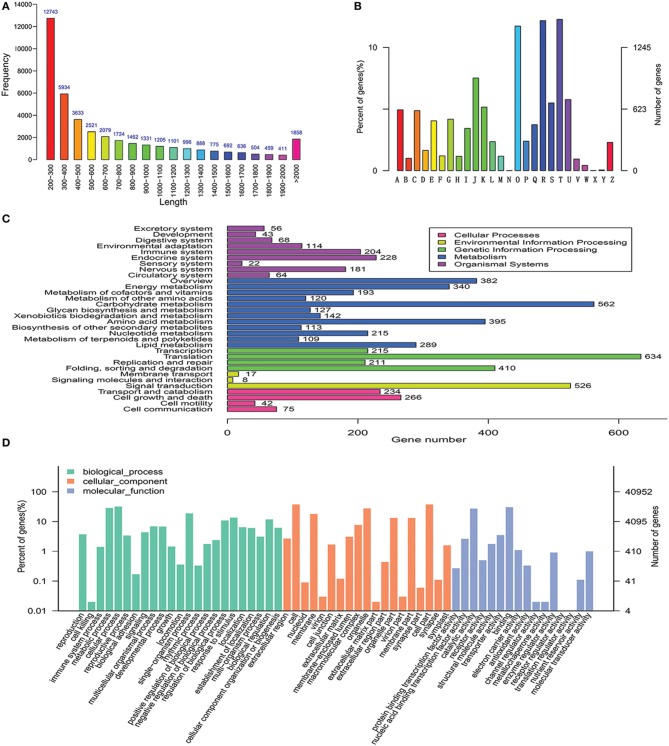
De novo assembly, annotation and functional classification. (A) Length distribution of the unigenes. (B) KOG classification assigned to unigenes. (C) KEGG classification of assembled unigenes. (D) Gene ontology classification of assembled unigenes. A, RNA processing and modification; B, Chromatin structure and dynamics; C, Energy production and conversion; D, Cell cycle control, cell division, chromosome partitioning; E, Amino acid transport and metabolism; F, Nucleotide transport and metabolism; G, Carbohydrate transport and metabolism; H, Coenzyme transport and metabolism; I, Lipid transport and metabolism; J, Translation, ribosomal structure, and biogenesis; K, Transcription; L, Replication, recombination, and repair; M, Cell wall/membrane/envelope biogenesis; N, Cell motility; O, Posttranslational modification, protein turnover, chaperones; P, Inorganic ion transport and metabolism; Q, Secondary metabolites biosynthesis, transport, and catabolism; R, General function prediction only; S, Function unknown; T, Signal transduction mechanisms; U, Intracellular trafficking, secretion, and vesicular transport; V, Defense mechanisms; W, Extracellular structures; X, Unnamed protein; Y, Nuclear structure; Z, Cytoskeleton.